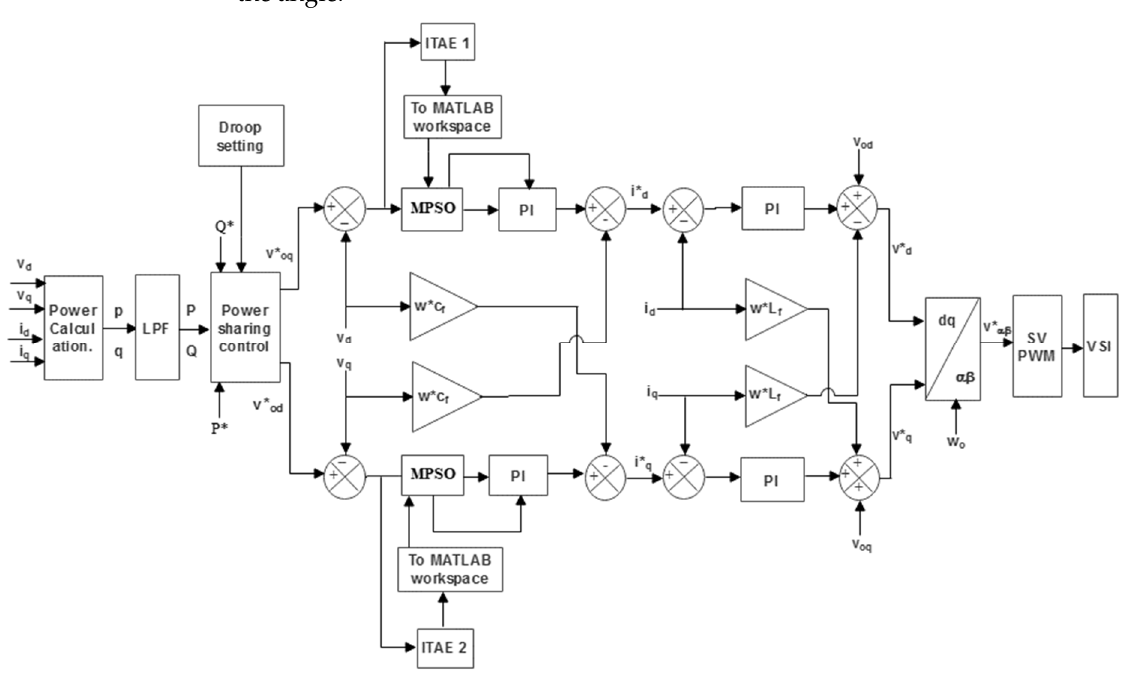
Figure 2. Proposed Power Control Strategy